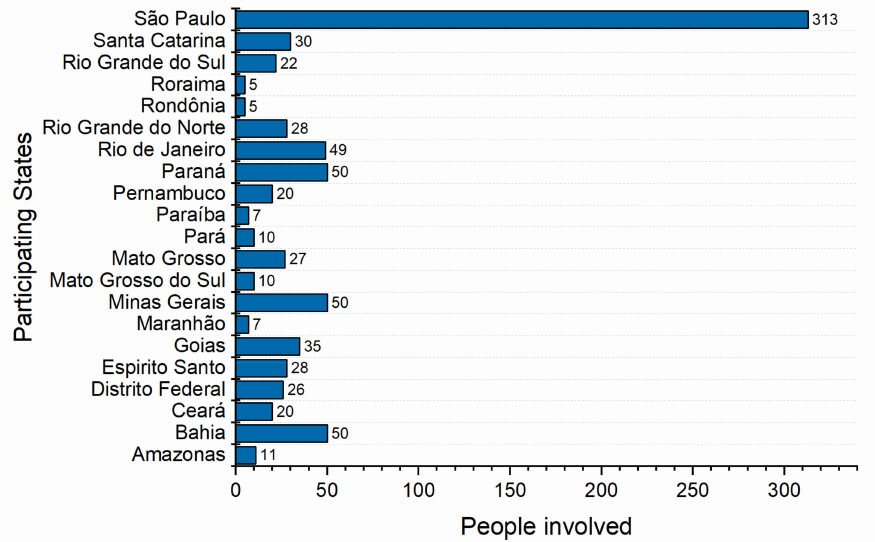
Figure 7. Distribution of people involved in I+M initiative per state of